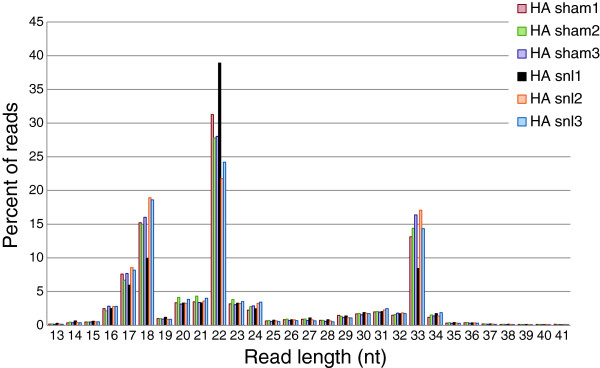
Histogram showing that the small non-coding RNAs in the rat DRG fall into three categories by size: 17–18 nt, 21–23 nt (miRNAs) and 32–34 nt. The HA_SNL1 pool (black columns) stands out as having relatively more miRNAs than the other pools.